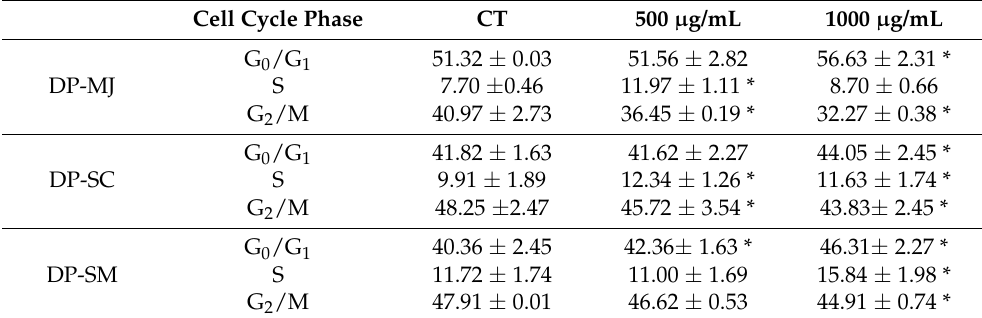
Results are expressed as a percentage of total cells. Significant differences between untreated cells (CT) and cells treated with DP-MJ. DP-SC and DP-MA (500–1000 µ g/mL) were compared (* p < 0.05; ** p <